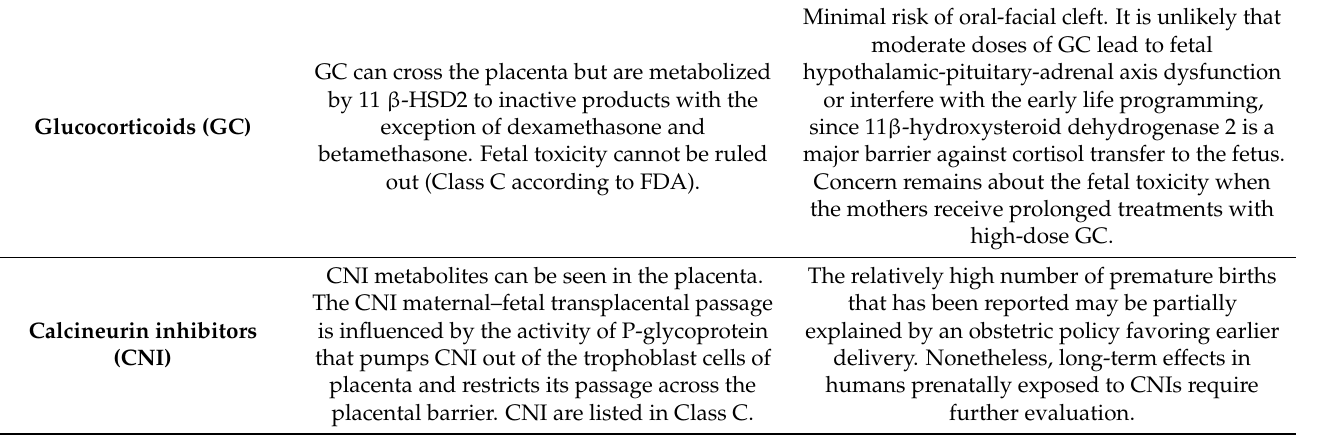
Table 2. Potential teratogenic effects of immunosuppressive